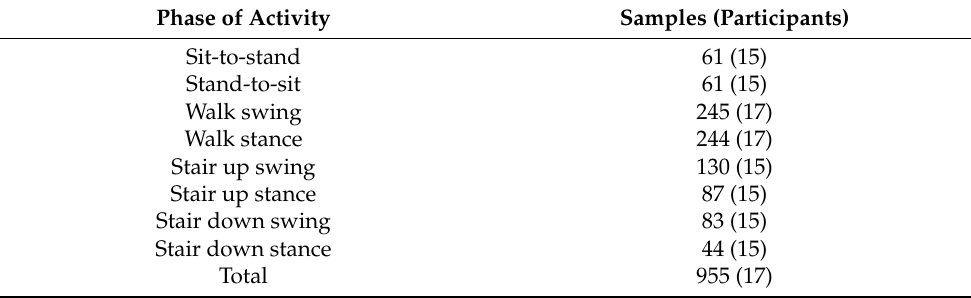
Table 1. Number of samples for each